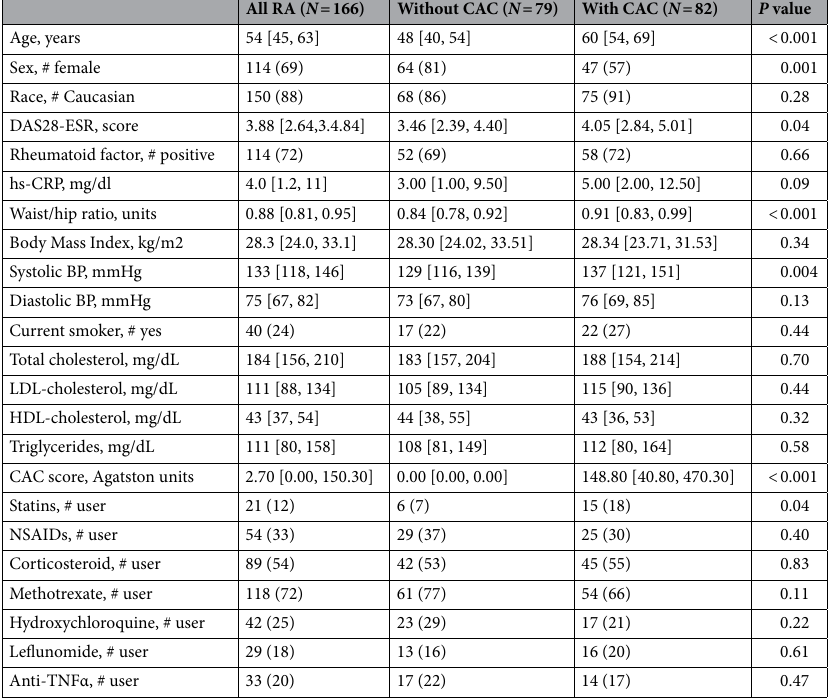
Table 1. Demographics and clinical